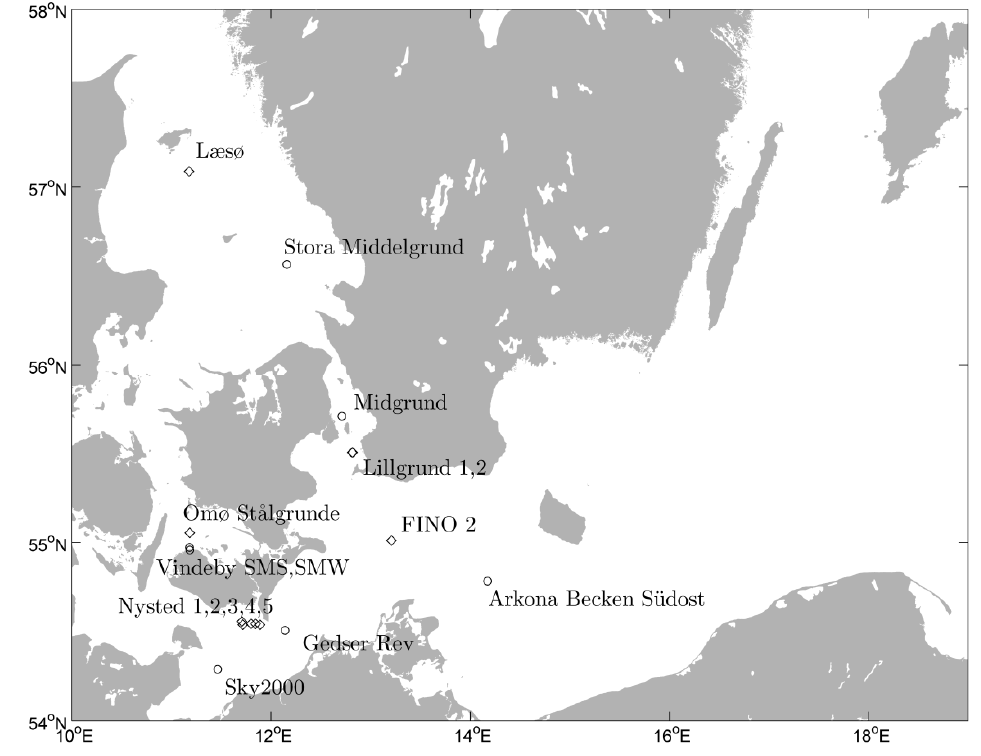
Figure 1. Map of the study area with indication of the 17 meteorological masts. Those indicated with ◊ are used in the comparison